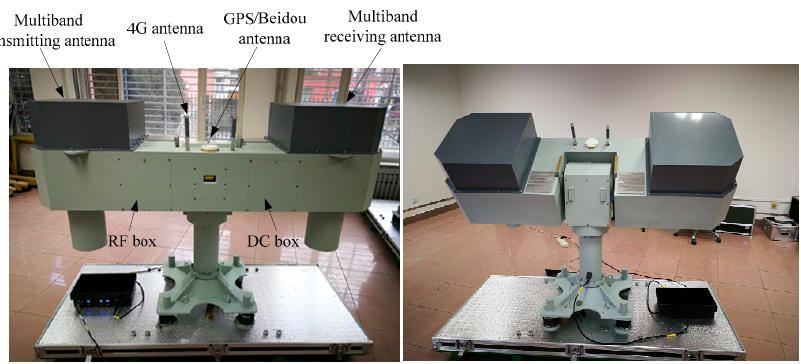
Figure 6. Outer view of the multi-band ARC.